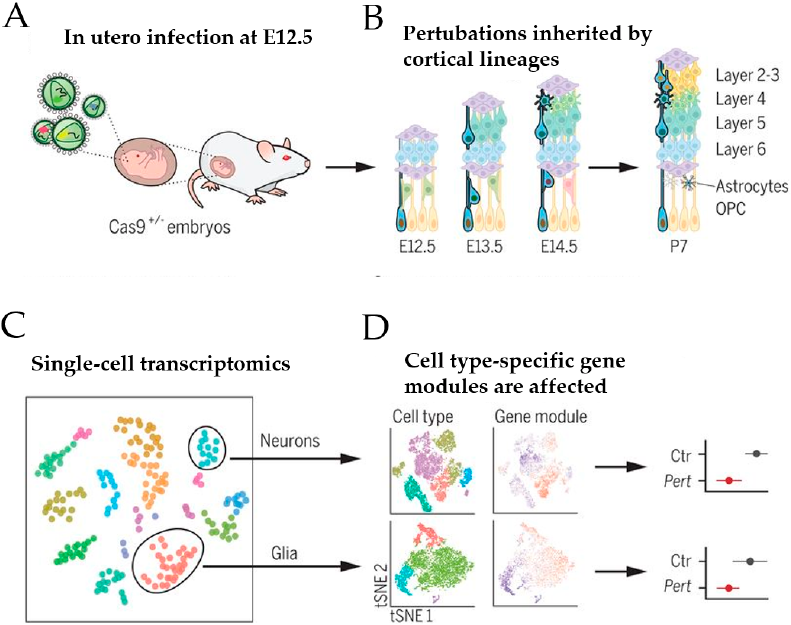
Figure 4. Schematic of in vivo Perturb-Seq analysis of mouse corticogenesis. ( A ) The lateral ventricles of Cas9 +/ − embryos were infected at E12.5 with lentiviral particles that contained a lentiviral guide RNA (gRNA) library targeting ASD/NDD risk genes. ( B ) ASD/NDD risk genes were gene-edited (“knocked-out”) in infected neural progenitor cells. These mutations were passed on to their progeny, including cells of the cortical lineage that form the upper and lower layer of the cortex. ( C ) At postnatal day 7, cortices were dissected and used for single-cell sequencing. ( D ) Gene expression modules were affected in a manner dependent on the individual gene perturbation and the specific cell type. Scheme adapted from [59], attribution license 5004760017864.